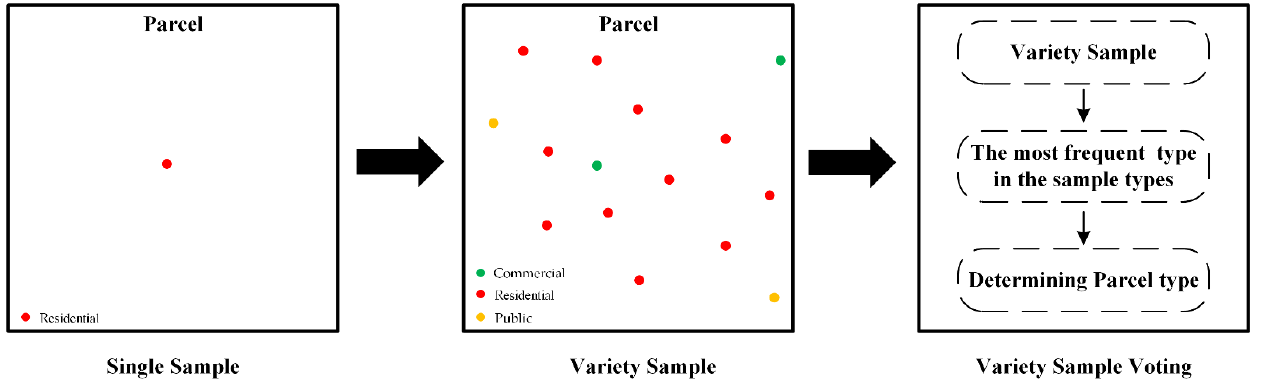
Figure 4. Multisample result voting selection process.